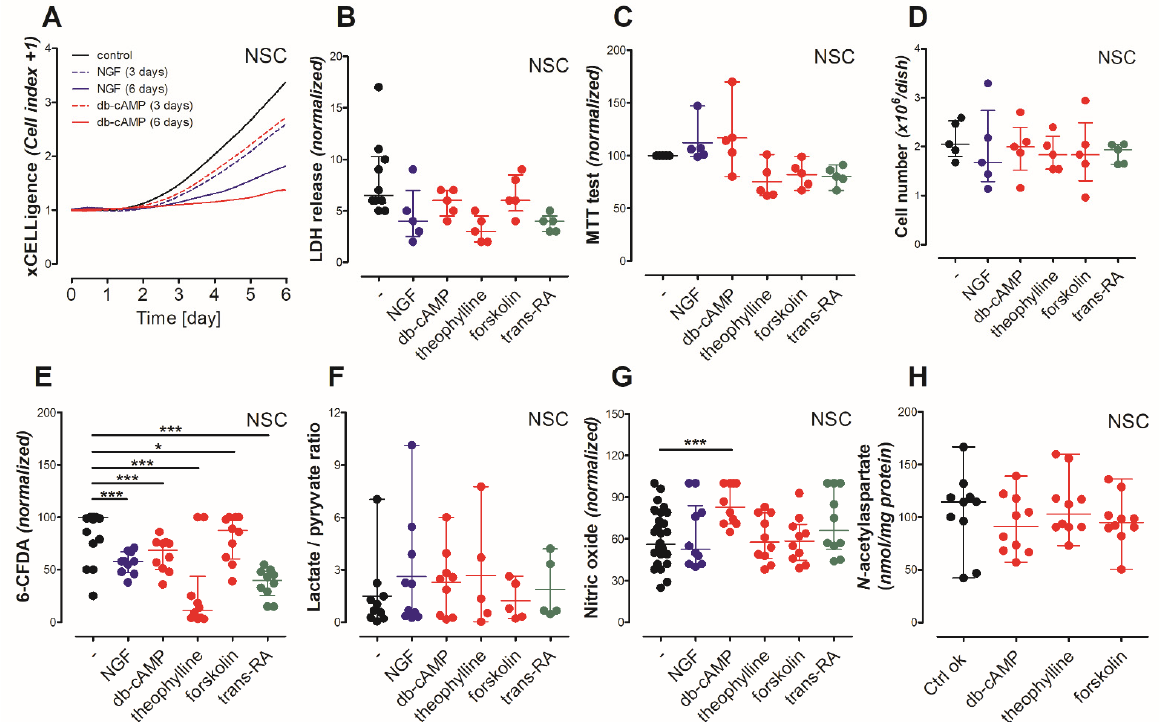
Figure 3. Impact of maturating factors on neural stem cell viability (6-day treatment): ( A ) xCELLigence real time measurement; ( B ) LDH in media test; ( C ) MTT test; ( D ) total number of cells; ( E ) 6-CFDA assay; ( F ) lactate/pyruvate ratio; ( G ) nitric oxide production; ( H ) N -acetylaspartate level. Results are shown as medians with interquartile ranges from 3–11 observations per group. ( B , C , E , G ): results were normalized according to the highest value in particular experiment. Results are showed as medians with interquartile ranges from 5–23 observations per group. Significantly different from the control: * ( p -value < 0.05), *** ( p -value < 0.001). Abbreviations: db-cAMP: dibutyryl-cyclic AMP, NGF: nerve growth factor, trans -RA: trans -retinoic acid.